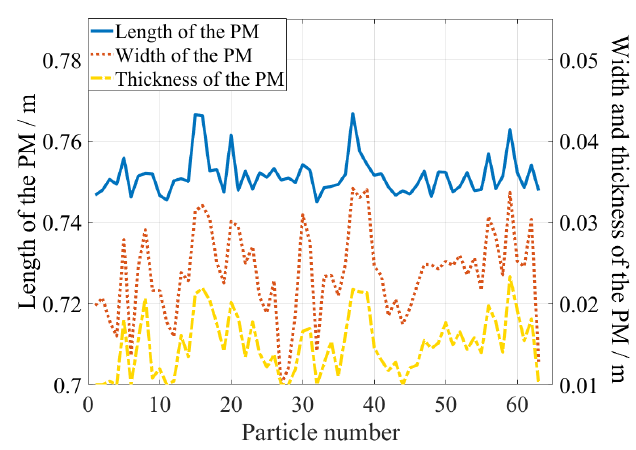
Figure 17. Length, width and thickness of the PM for each